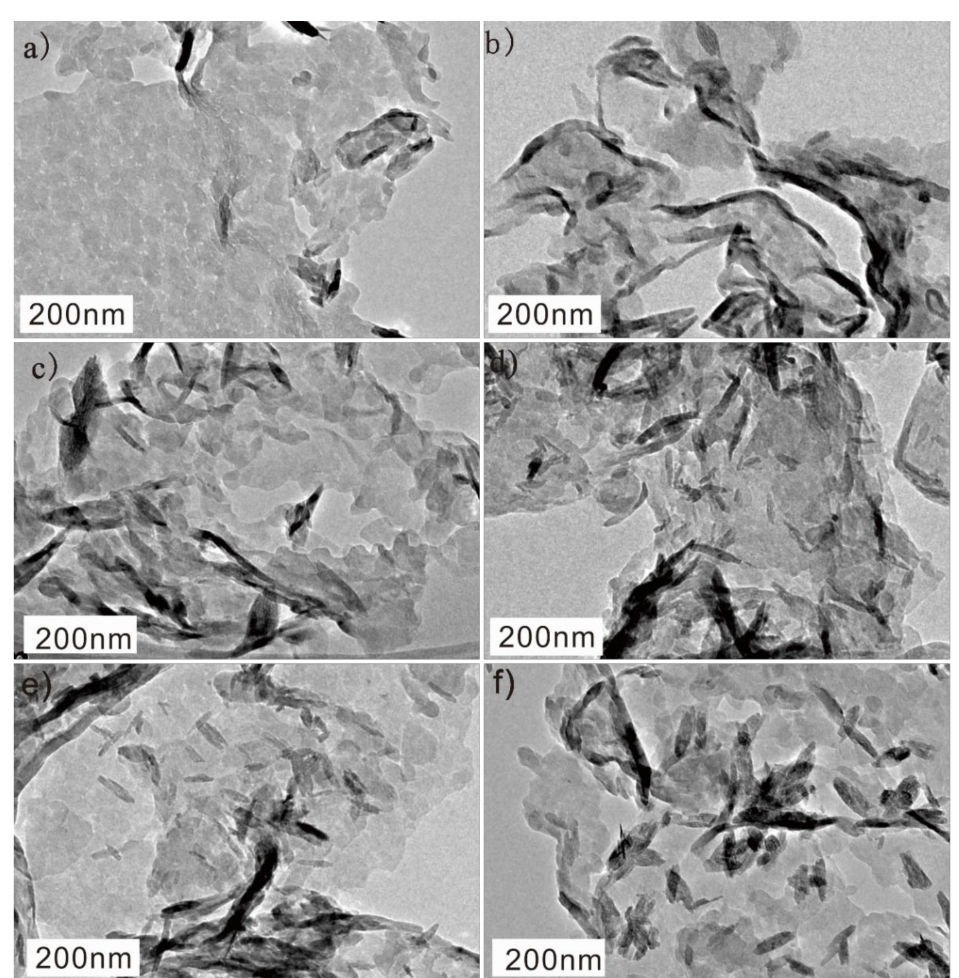
Figure 2. TEM images of all samples: g-C 3 N 4 ( a ), 0.5Fe( Ш )-CN ( b ), 1Fe( Ш )-CN ( c ), 2Fe( Ш )-CN ( d ), 4Fe( Ш )-CN ( e ) and 8Fe( Ш )-CN ( f ).